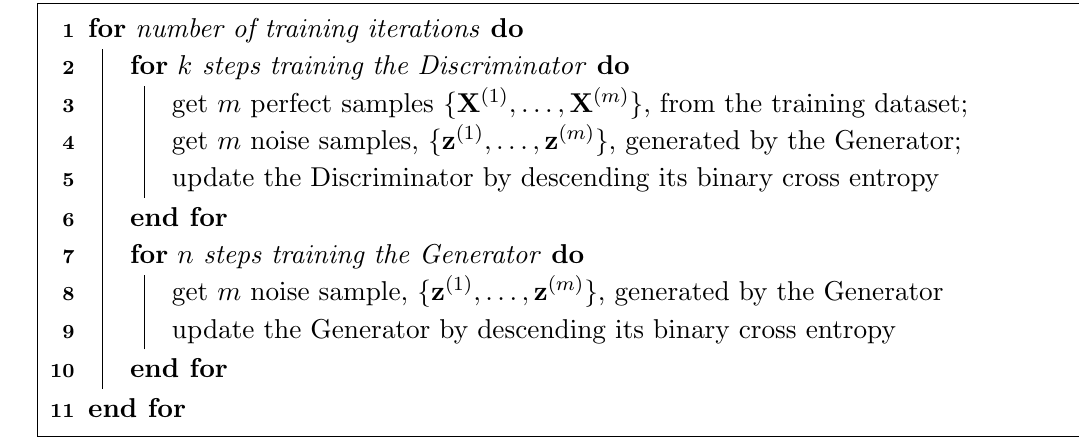
Algorithm 2 . Training the Generative Adversarial Network